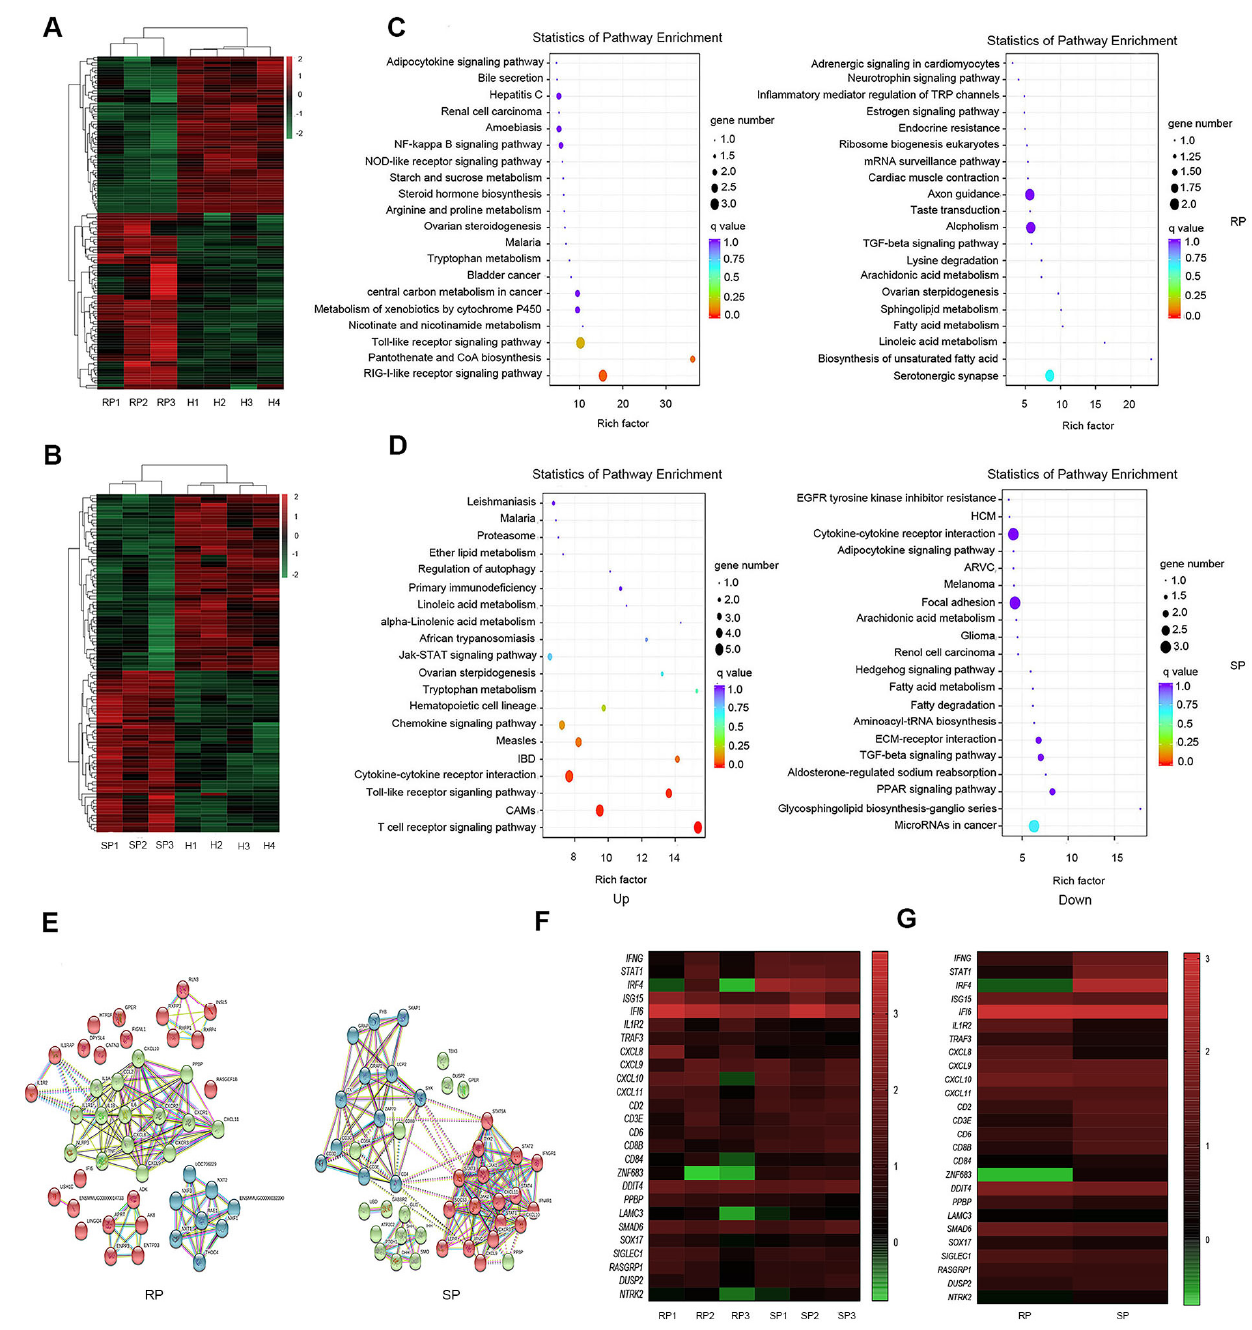
Figure 3. Transcriptomic characteristics in the lungs of the SP and RP groups after infection. Heatmap of DEGs after infection in the RPs ( A ) and SPs ( B ). Scatter diagrams of the enriched metabolic pathways of the DEGs (gene with up- and downregulated expression) are shown for the RPs ( C ) and SPs ( D ). Each dot represents a metabolic pathway, the ordinate shows the name of the pathway, and the abscissa shows the enrichment factor, indicating the proportion of DEGs annotated to the pathway compared to the proportion of all genes annotated to the pathway. ( E ) PPI network of the DEGs during primary infection with SIVmac239 in the RPs and SPs. The nodes represent proteins, and the edges represent protein–protein interactions. Heatmaps of several DEGs in every infected sample ( F ) and the two groups ( G ) are shown. The color represents the expression level: from green to red indicates that the expression level is from low to high. SP: n = 3, RP: n = 3, SIV-: n =